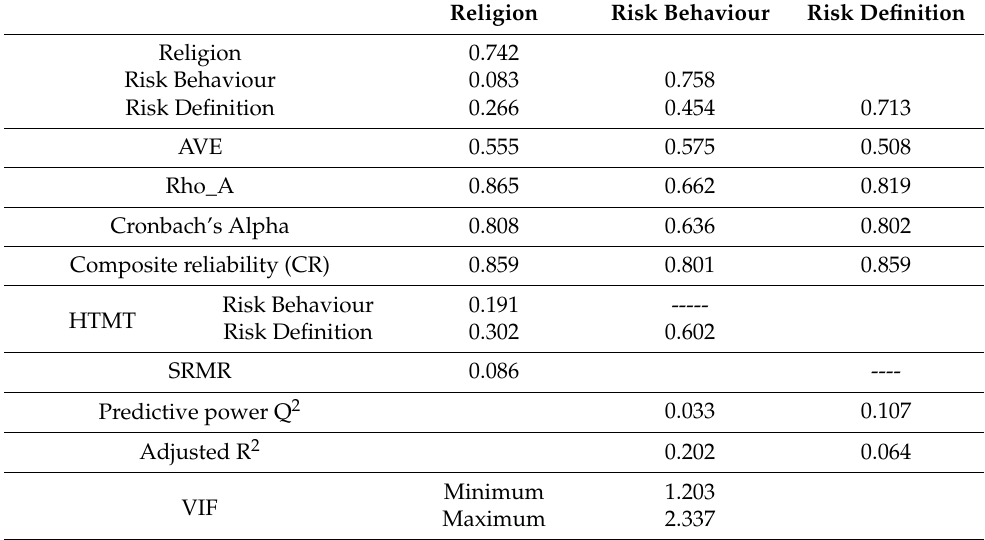
Table 4. Evaluation of Reflective Measurement Models and Structural Models for Model